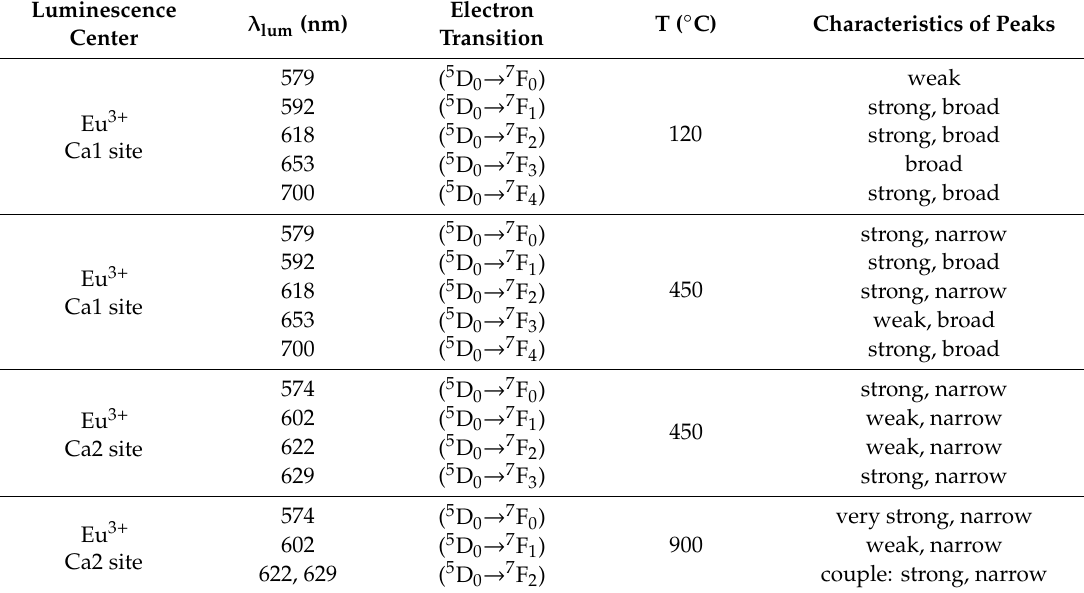
Table 8. Photoluminescence (PL) transitions of Eu 3 + in Ca1 and Ca2 sites after thermal treatment at 120, 450 and 900 ◦